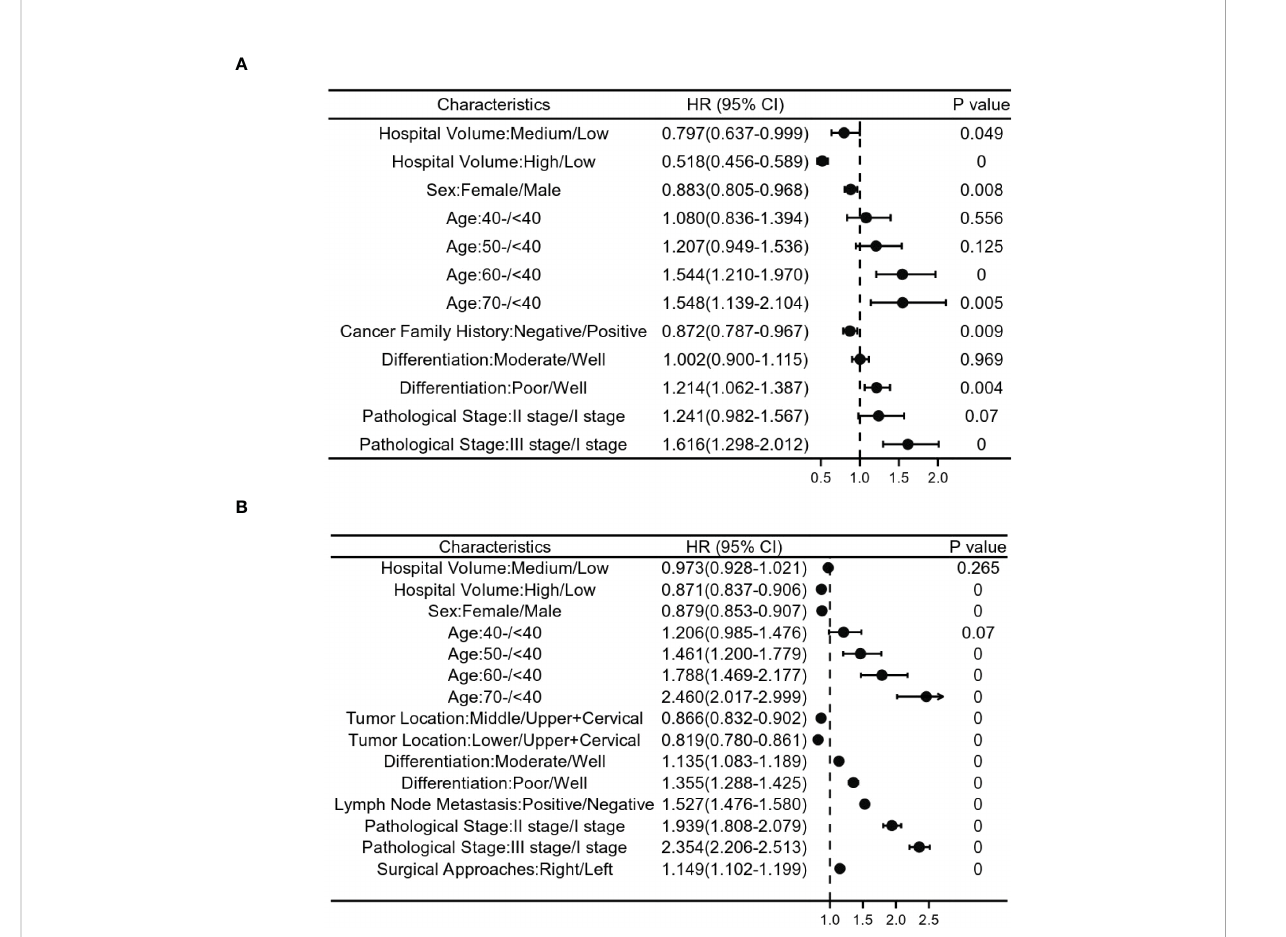
FIGURE 4 Relationship between clinicopathological features and postoperative survival risk in patients with stages I-III esophageal cancer. (A) shows patients with esophageal cancer from 1973 to 1996, and (B) ITom 1997 to 2020. Risk ratios based on hospital volume, age, sex, cancer family history, differentiation,tumor location, lymph node metastasis, surgical approaches and pathological